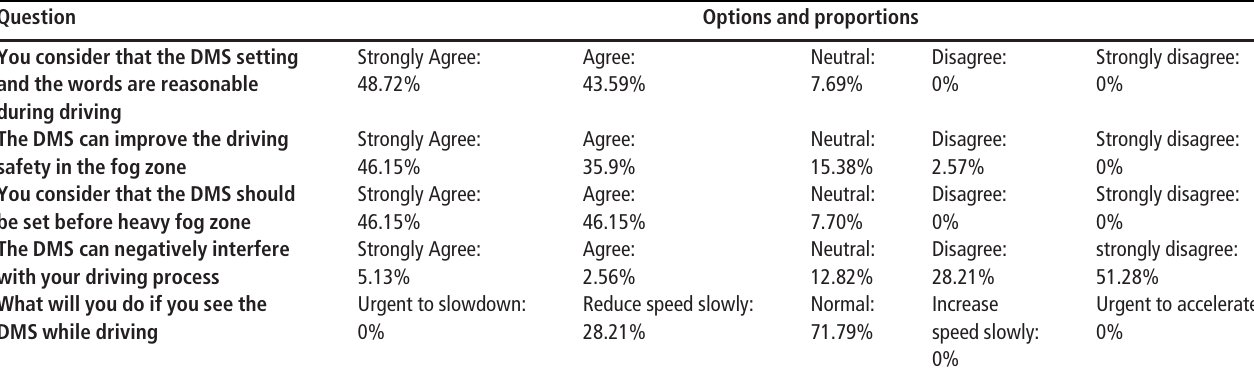
Table 3 Design and results of subjective